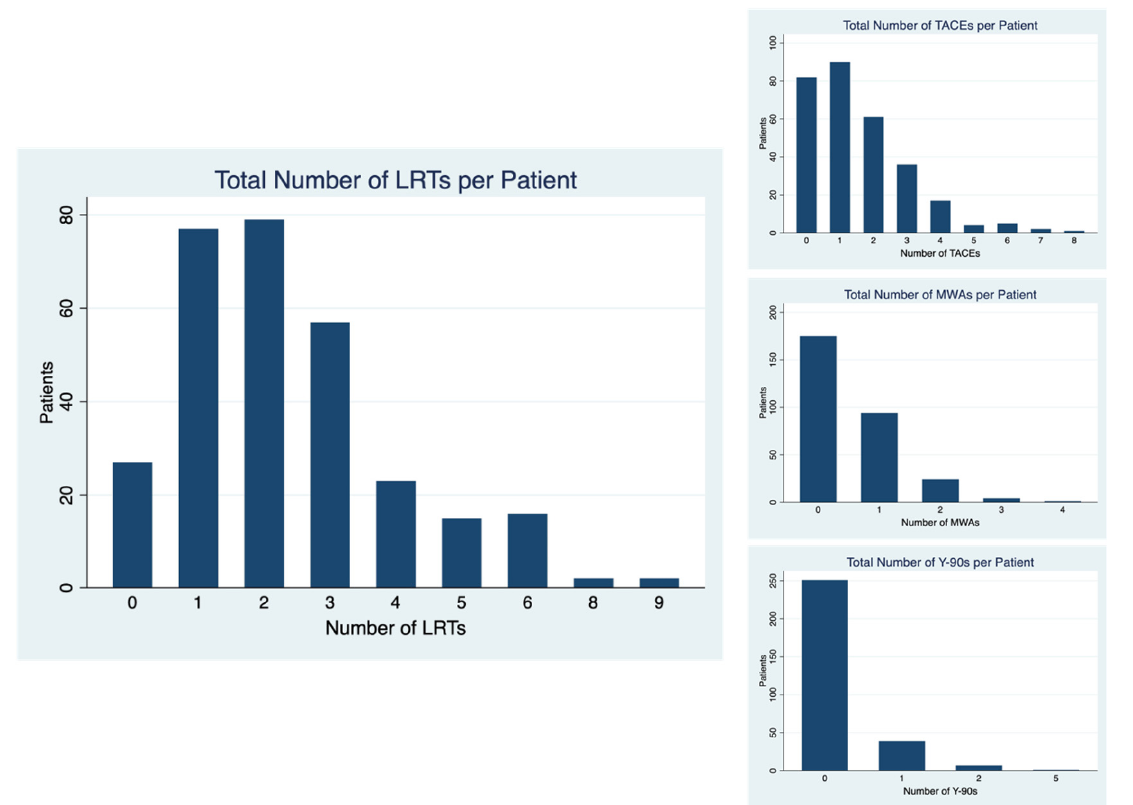
Figure 1. Number and Type of LRTs per Patient. LRT = Local Regional Therapy, TACE = Transarte ‐